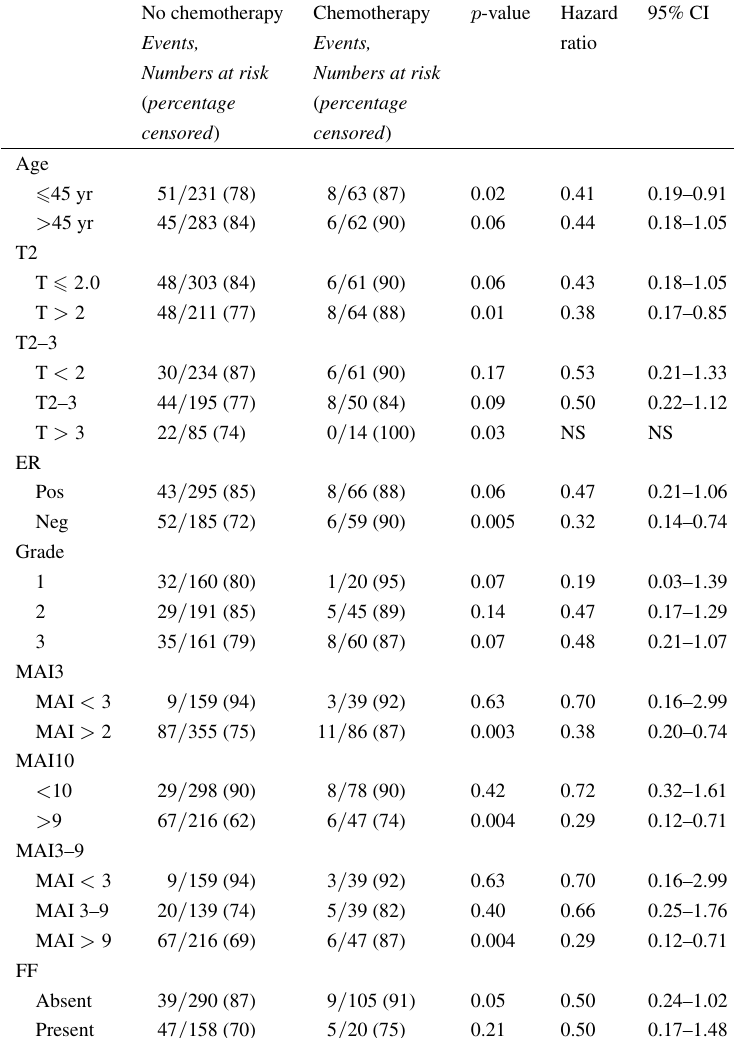
Overall Survival in the total population of 639 lymph node-negative patients under 55 years, di- vided in chemotherapy vs no chemotherapy. For the MAI, only the most significant thresholds are